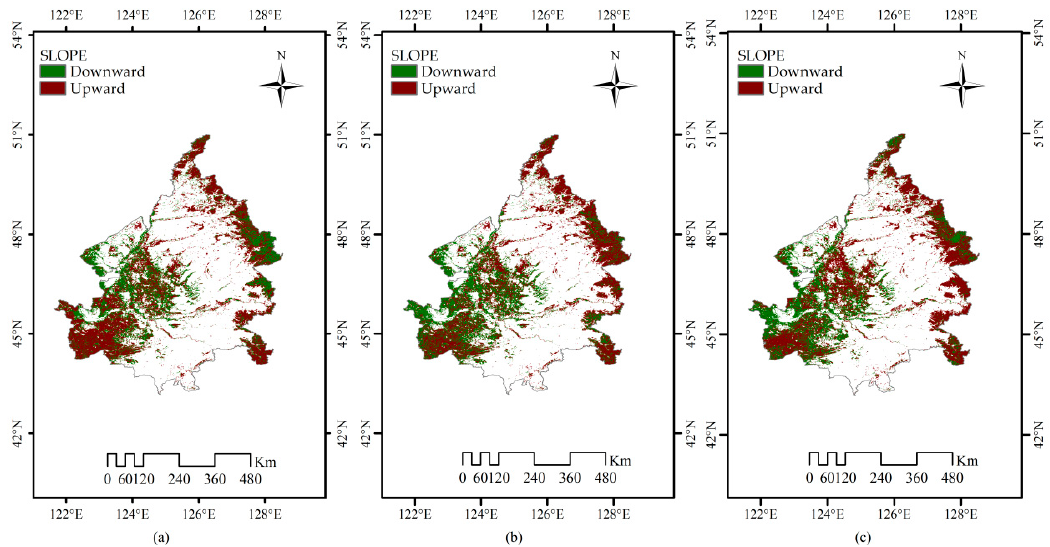
Figure 7. Spatial trend of average CUE in each season of SNP from 2001 to 2015. ( a ) Spring; ( b ) summer; ( c ) autumn.